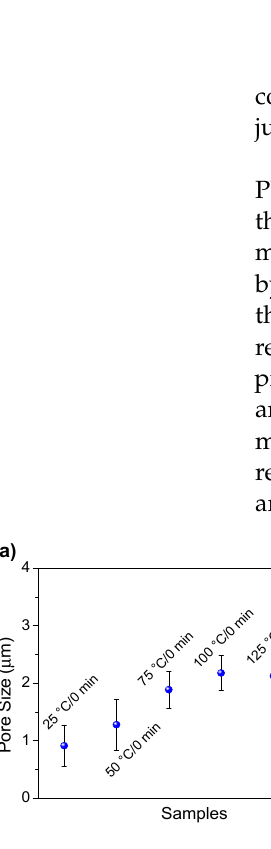
Figure 4. ( a ) Cross section pore size (excluding the finger like macropores), ( b ) porosity and ( c ) top and bottom surface water contact angles of representative PVDF membranes as a function of the dissolution temperature.